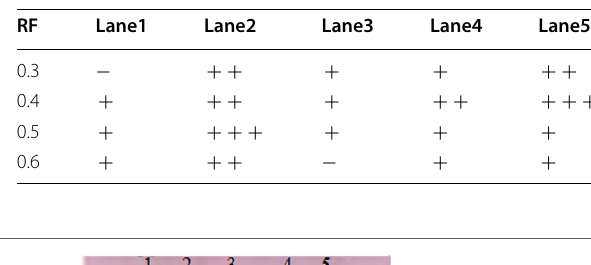
Table 4 Effect of A . terreus on polyphenol oxidase isozyme of